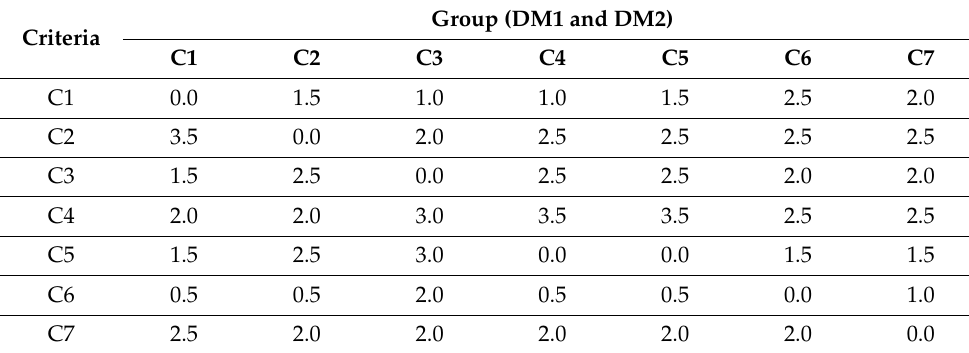
Table 5. DEMATEL direct influence matrix — group context.